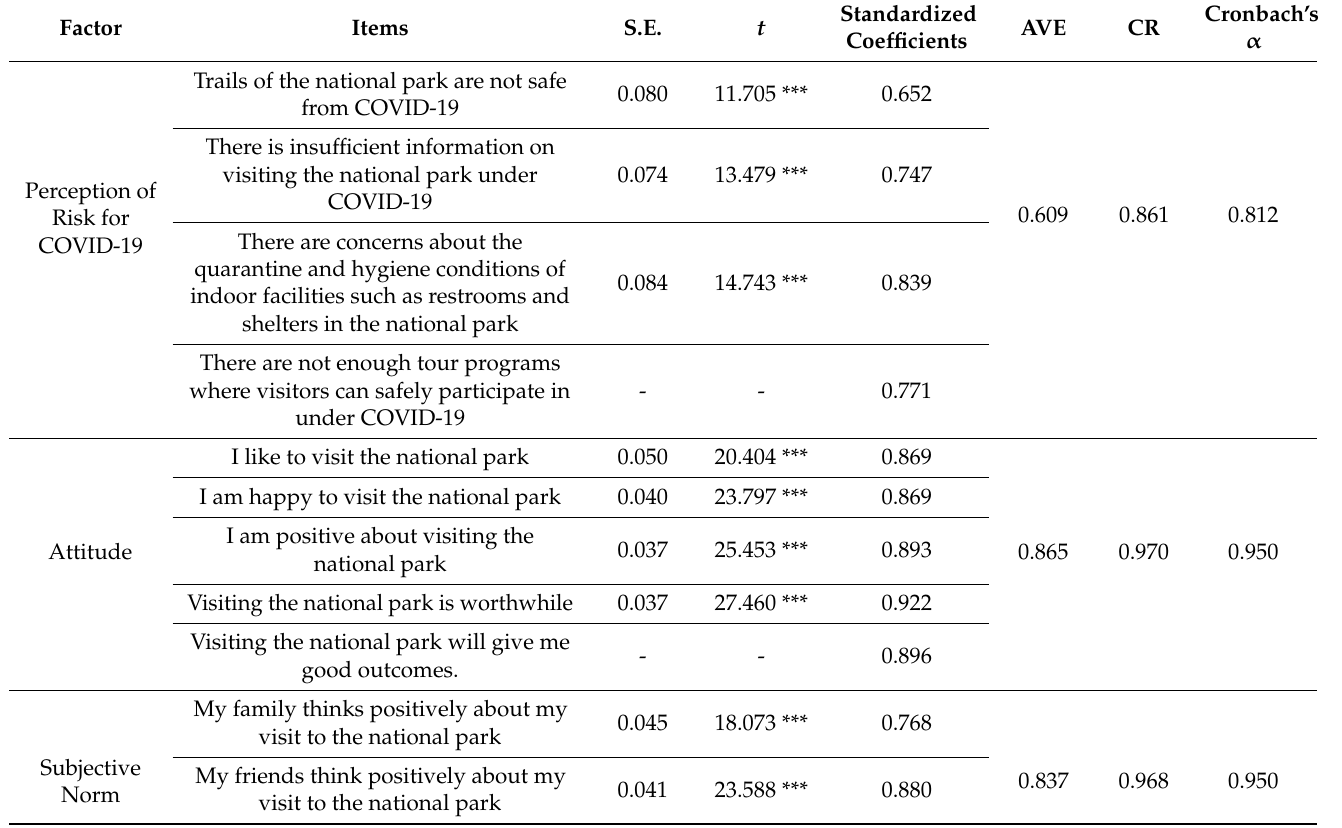
Table 2. Convergent validity and reliability of the